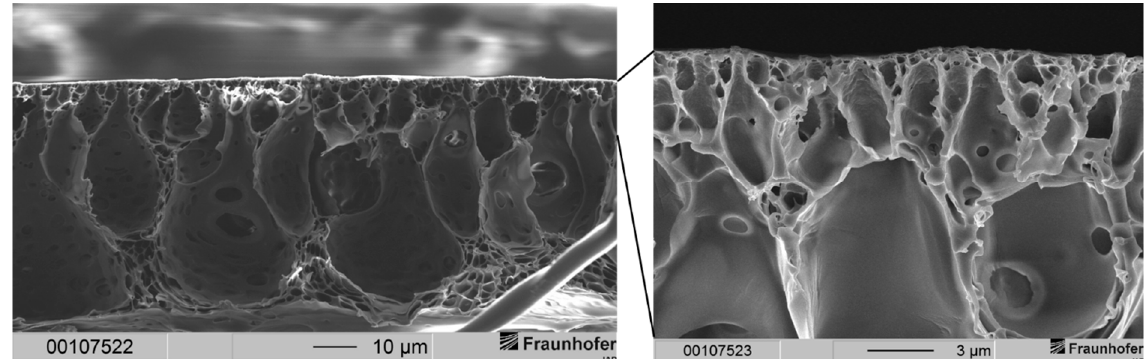
Figure 6. ( Left ) Cross-section of an integrally skinned PSU flat sheet membrane without PDMS protective layer. The PSU concentration was increased to 30 wt.-%. Solvent ration was kept constant. The precipitation medium used was distilled water. ( Right ) Enlarged view of the top layer with dense separation layer and macrovoids.